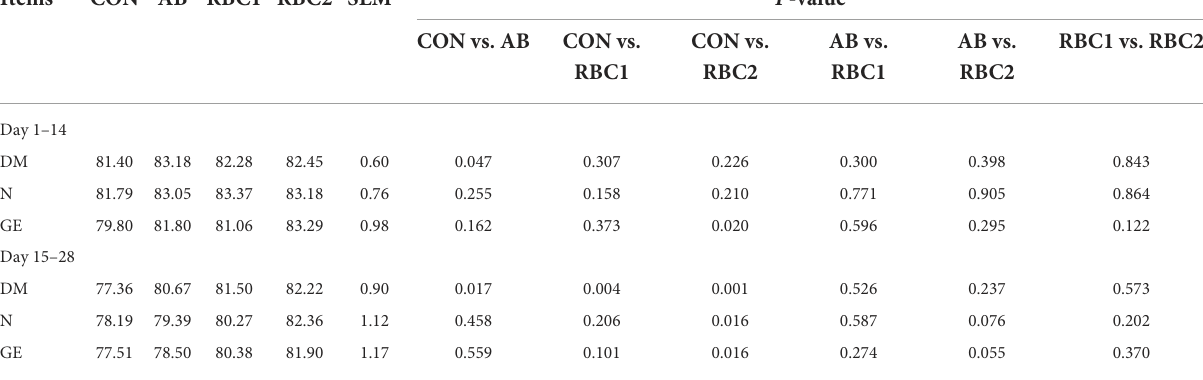
TABLE 4 Effect of dietary RBC and AB supplementation on nutrients digestibility of weaning piglets